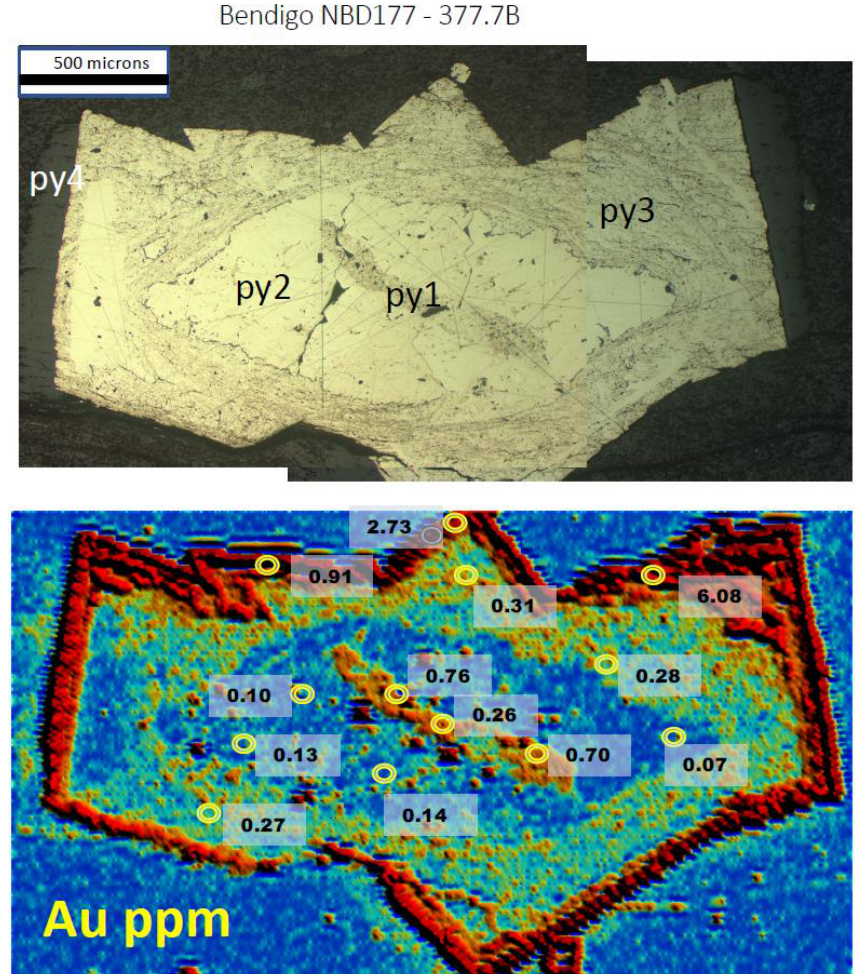
Figure 2. Pyrite aggregate from the pyritic halo of a Bendigo quartz-Au lode [27]. Top panel ( A ), photomicrograph reflected light of the pyrite aggregate showing the pyrite zones, py1 core, py2, py3 and py4 rim. Bottom panel ( B ), LA-ICPMS map of Au; colours from blue, green, yellow, orange and red represent increasing gold content on a log scale. Numbers in grey oblongs are spot analyses in ppm Au, by LA-ICPMS.